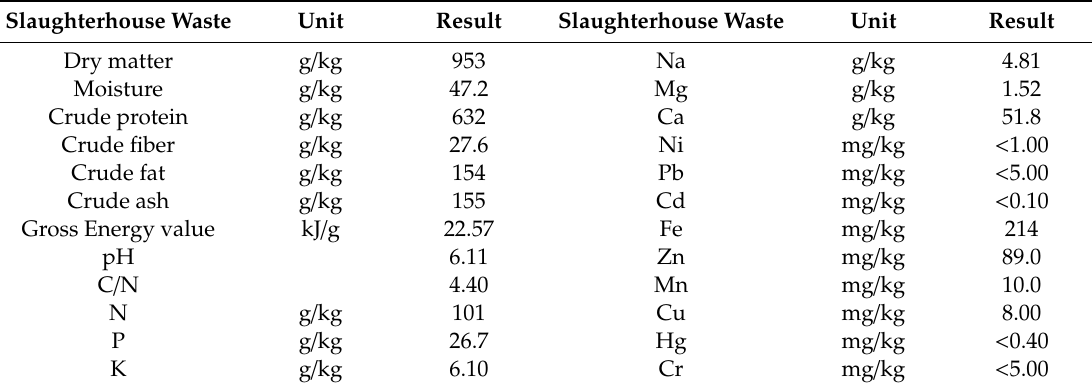
Table 1. Analysis of dry